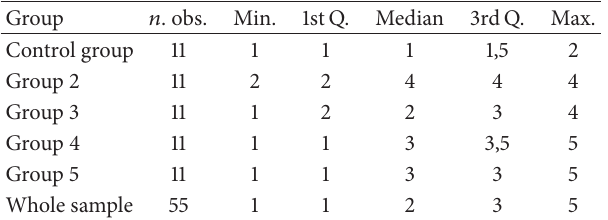
Table 1: ARI score in whole sample and within